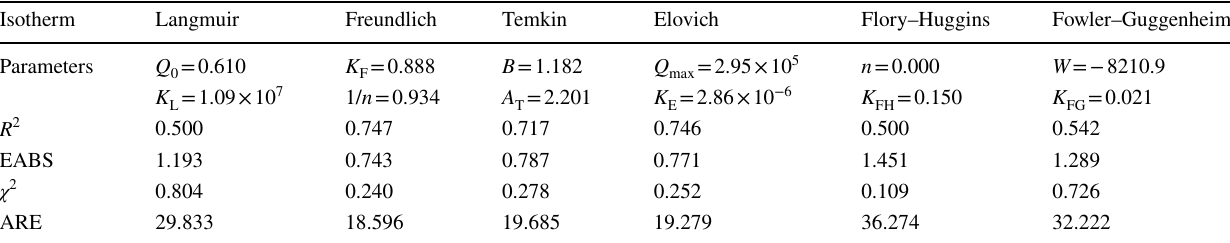
Table 4 Nonlinear isotherm model parameters for MB adsorption onto Fe